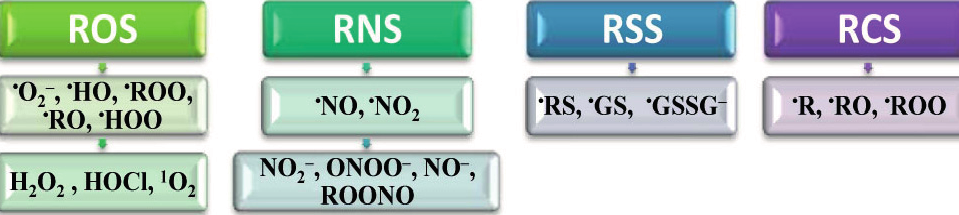
Figure 2. Classification of reactive species (RS) in living systems. Depending on the active center ( ac ) they are classified as: reactive oxygen species (ROS), ac -oxygen; reactive nitrogen species (RNS), ac -nitrogen; reactive carbon species (RCS), ac -carbon and reactive sulfur species (RSS), ac -sulfur.